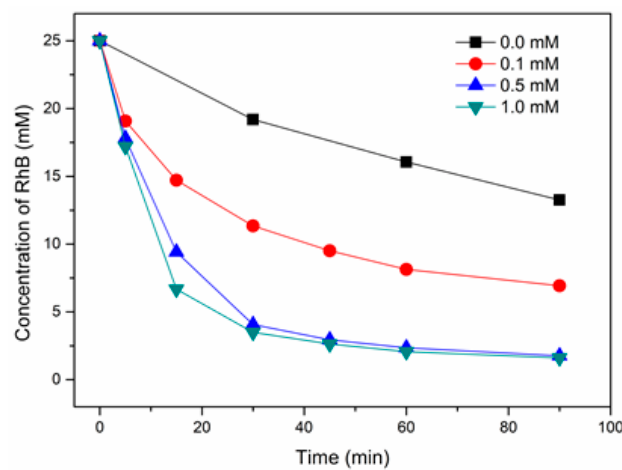
Figure 3. Effect of HA concentration on RhB degradation at pH 5. Concentrations: [Sch] = 0.5 g/L, [RhB] = 25 mM, [PS] = 5 mM, and [HA] = 0–1 mM.